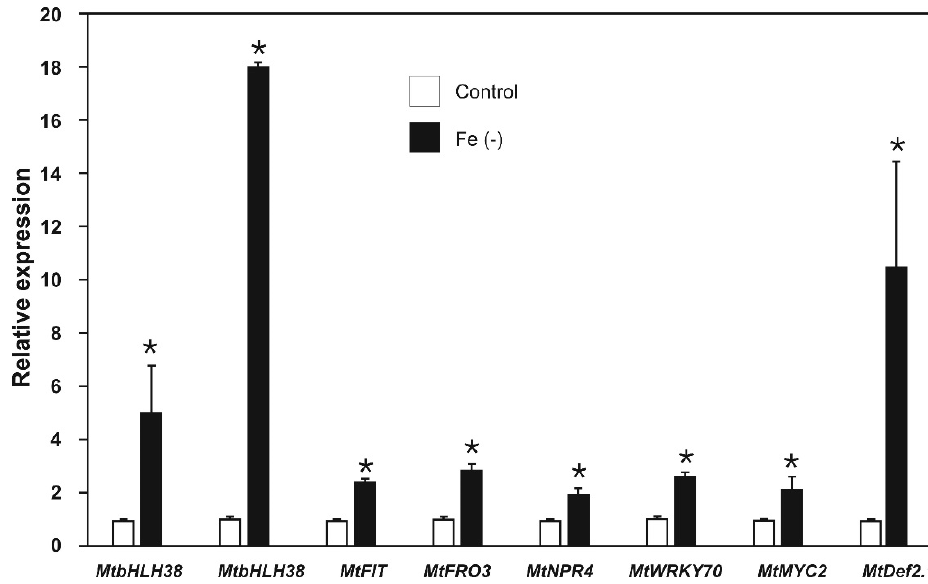
Figure 5. Relative expression of iron uptake and defense genes in Medicago truncatula plants grown under both iron-sufficient (control) and iron-deficient conditions for 48 h. Values represent mean ± standard errors of relative expression in reference to controls. Asterisks indicate significant differences between treatments calculated using Student’s t test ( p < 0.5; n = 3).